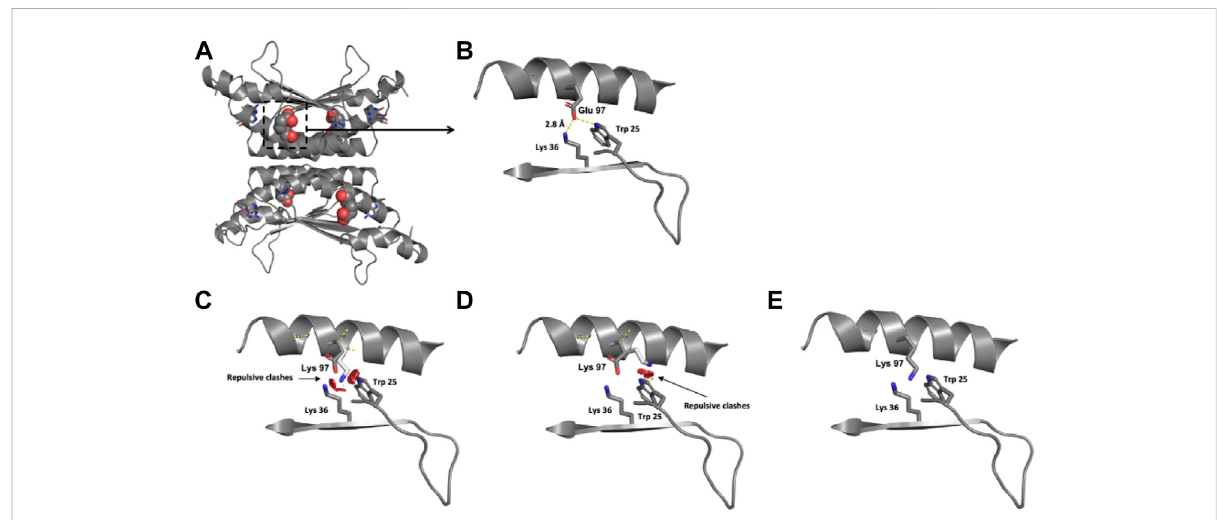
FIGURE 6 Modeling of human PCD structure with p.(Glu97Lys) change. (A) Crystallographic structure of a dimer of PCBD1 and location of the Glu 97 residues on each monomer. (B) Location of the Glu 97 residue in one monomer. (C – E) Potential pathogenic effects for the substitution of Glu by